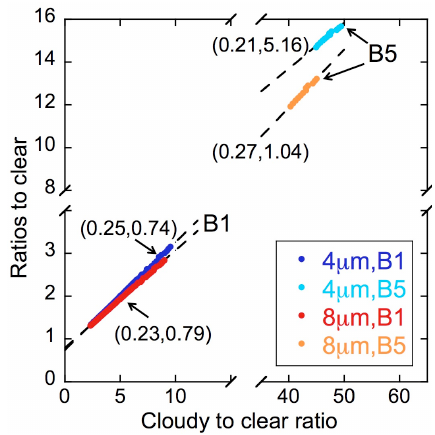
Figure 4. Spectrally-invariant linear relationships at τ c = 0.5, derived from band B1 (400–870 2 Fig. 4. Spectrally-invariant linear relationships at τ c = 0.5, de- nm) and band B5 (2110–2220 nm), for cloud drop effective radius values of 4 and 8 µm. 3 rived from band B1 (400–870nm) and band B5 (2110–2220nm), for cloud drop effective radius values of 4 and 8µm. Numbers in Numbers in parentheses are the slope and intercept of the linear regression relationships (dashed 4 parentheses are the slope and intercept of the linear regression rela- lines). 5 tionships (dashed